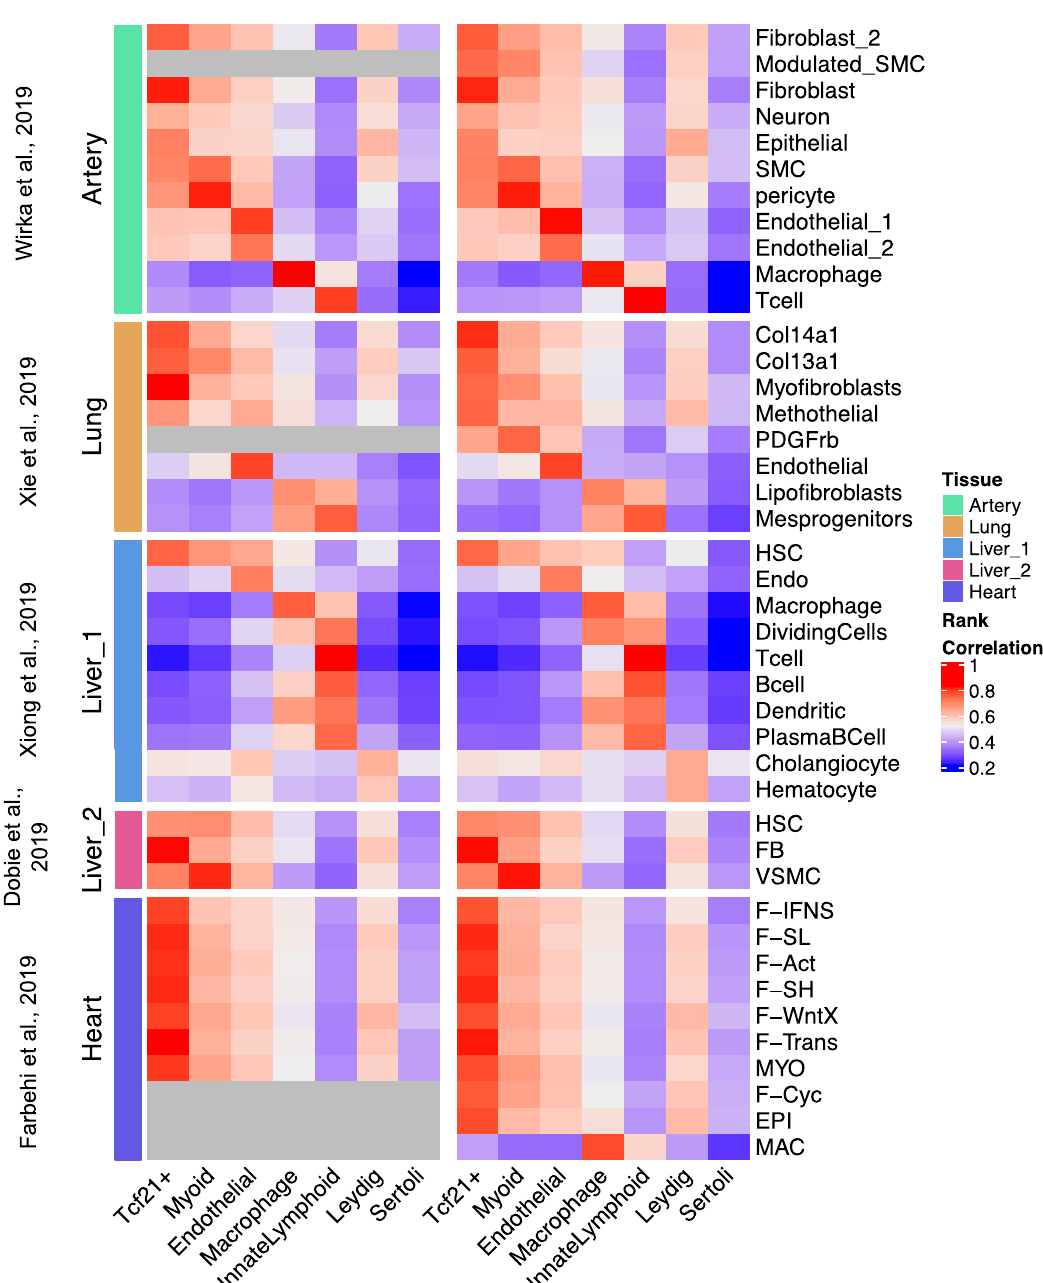
Fig. 7 The adult Tcf21 + interstitial population resembles fi broblasts in other tissues. A Rank correlation of scRNA-seq cluster centroids of somatic cells from wild-type adult mouse testes with other tissues in healthy adult mice (left panels) or after injury (right panels). Gray blocks indicate cell types not present in healthy